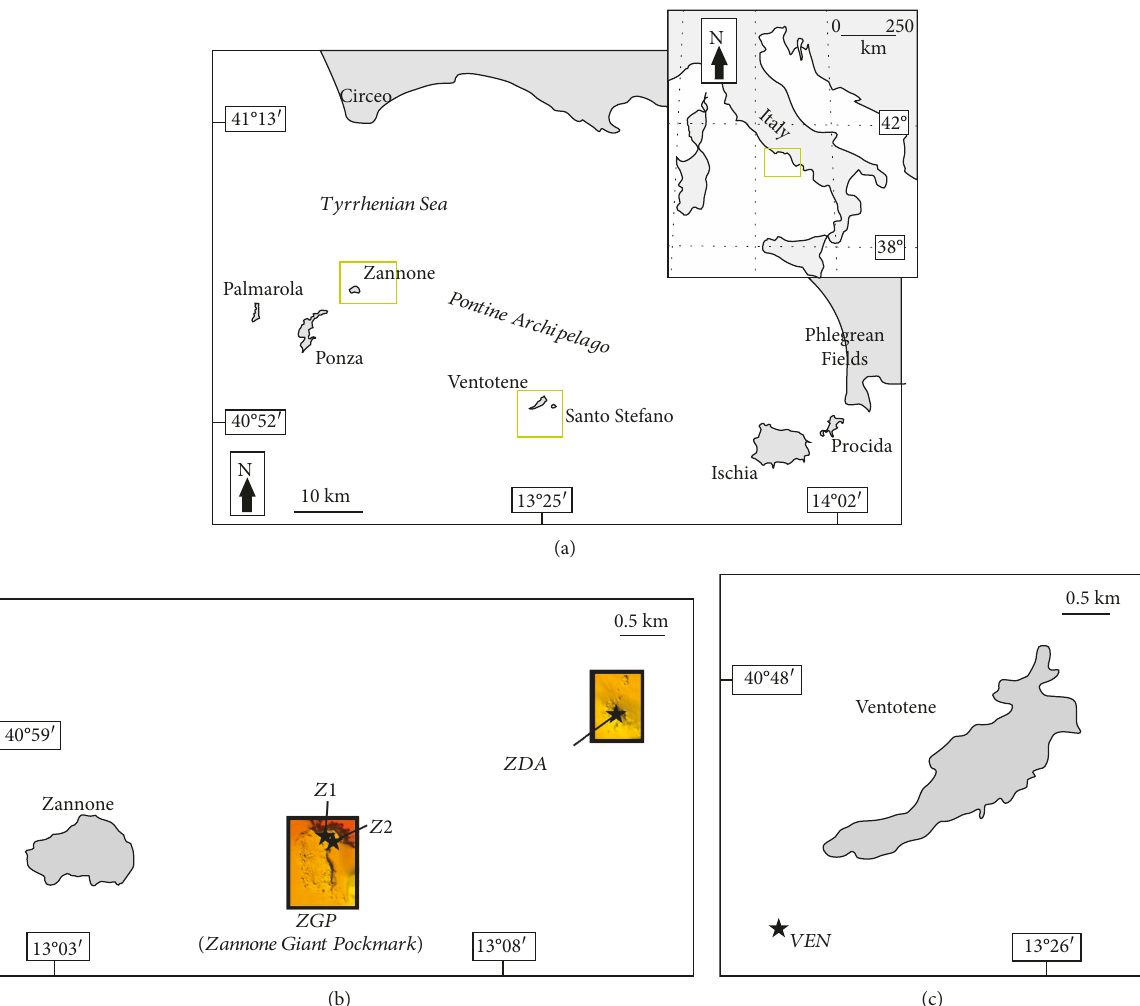
Figure 1: (a) Sketch map of the central Tyrrhenian margin with the location of the areas investigated; (b) location map of the Zannone studied sites (after Martorelli et al. [27]). See Ingrassia et al. [26] and Martorelli et al. [27] for further information; (c) location map of the VEN site lying south to the island of